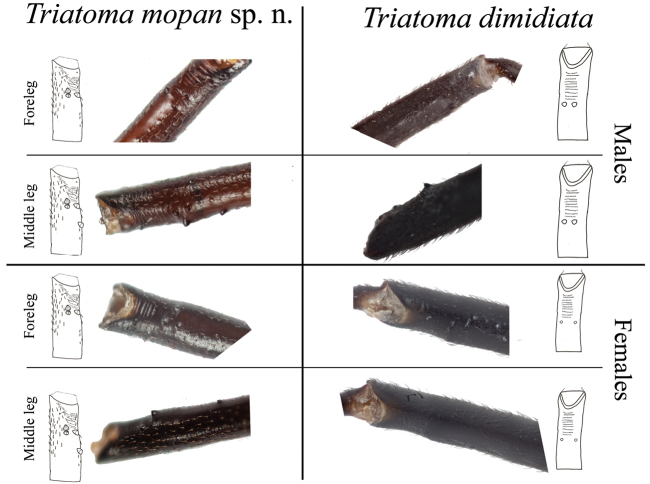
Comparison between the fore and mid femora of T.
mopan and T.
dimidiata from Jutiapa, Guatemala. Drawings: Carolina Dale. Photographs Silvia Justi.